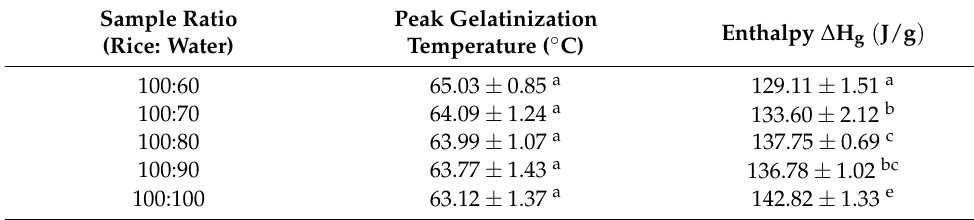
Figure 7. DSC thermograms for rice paste samples at different moisture ratios. Table 3. Gelatinization temperature and enthalpy